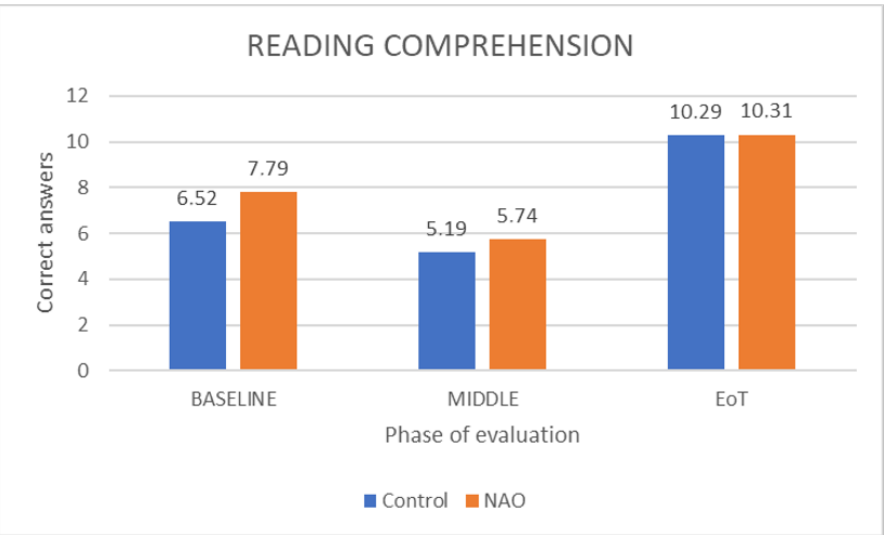
Figure 3. Correct answers in reading comprehension at the beginning (baseline), at the middle and at the end of treatment (EoT) for both groups.